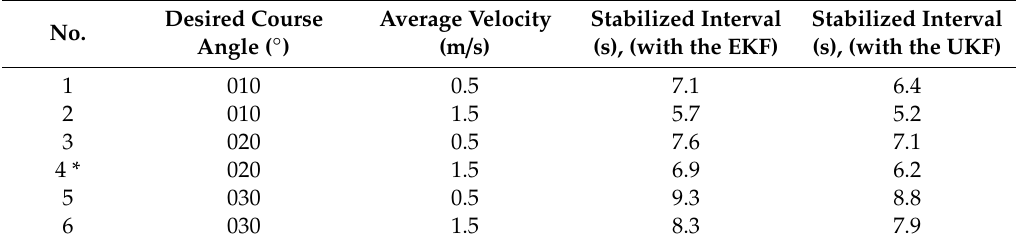
Table 4. Testing results for the course-tracking of the torpedo-shaped AUV.